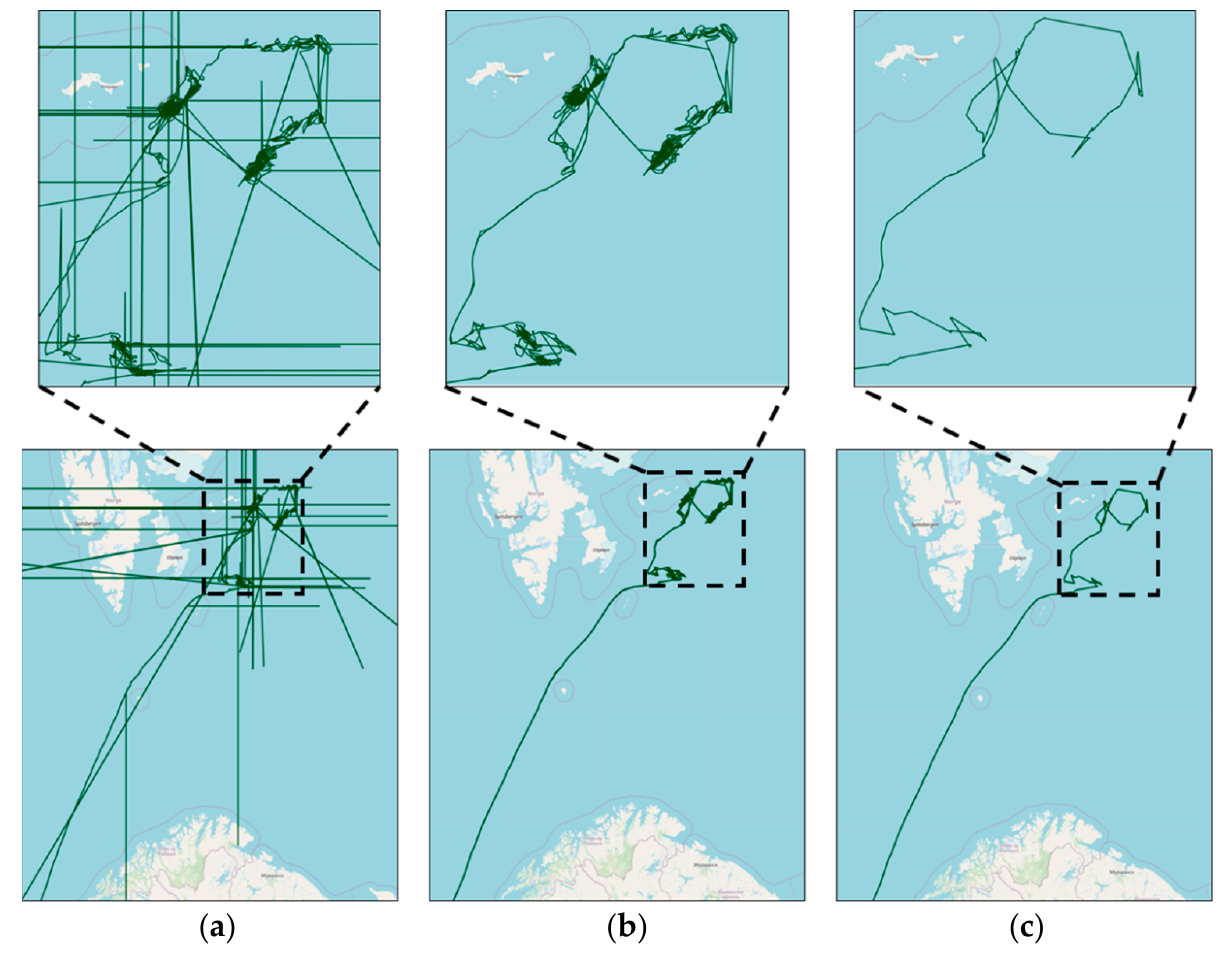
Figure 10. Comparison of denoising Effects of MMSI 218832000. ( a ) Data preprocessing; ( b ) data cleaning; ( c ) trajectory reconstruction. Table 4. Trajectory information for different MMSIs.